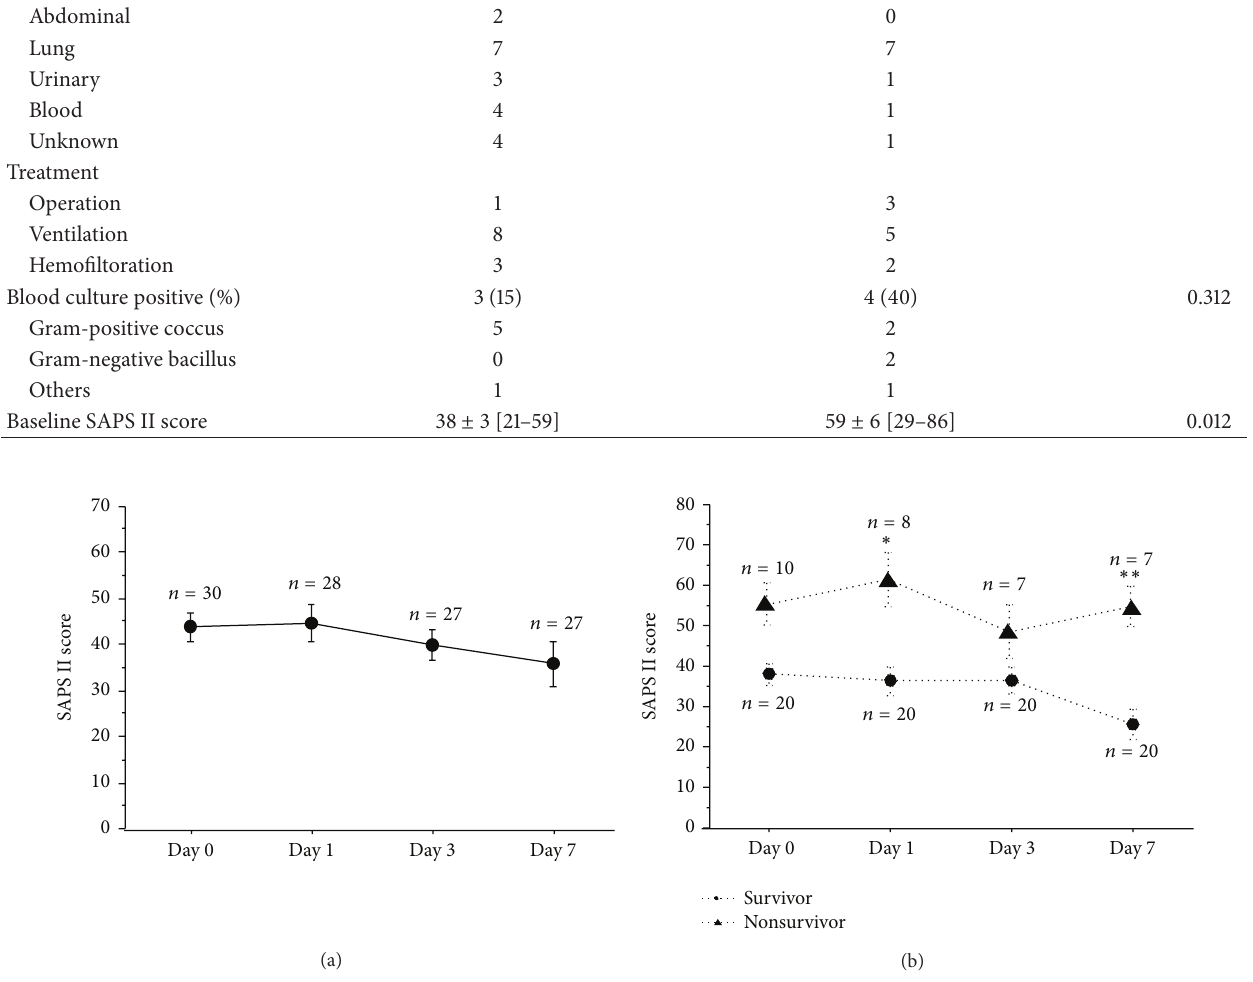
Figure 1: Changes of SAPS II score. SAPS II score was over 40 on Day 0 and the score was sustained over 35 throughout the study period (a). SAPS II score was compared between the survivors group and nonsurvivors group (b). Nonsurvivors group showed significantly higher scores on Day 1 and Day 7. SAPS II: Simplified Acute Physiology Score II, ∗ 𝑝 < 0.05 , ∗∗ 𝑝 < 0.01